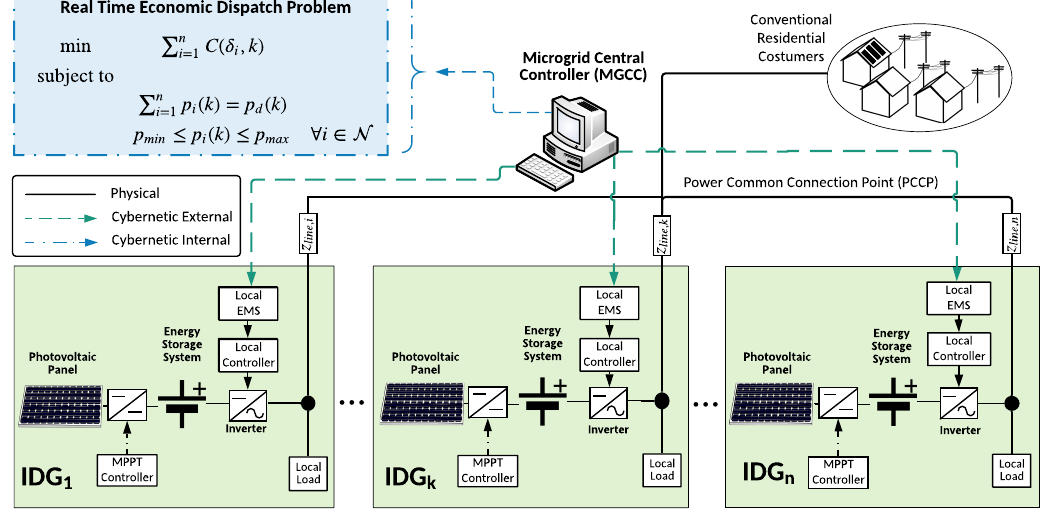
Figure 1. Prosumer Microgrid Architecture and the Real-time Economic Dispatch